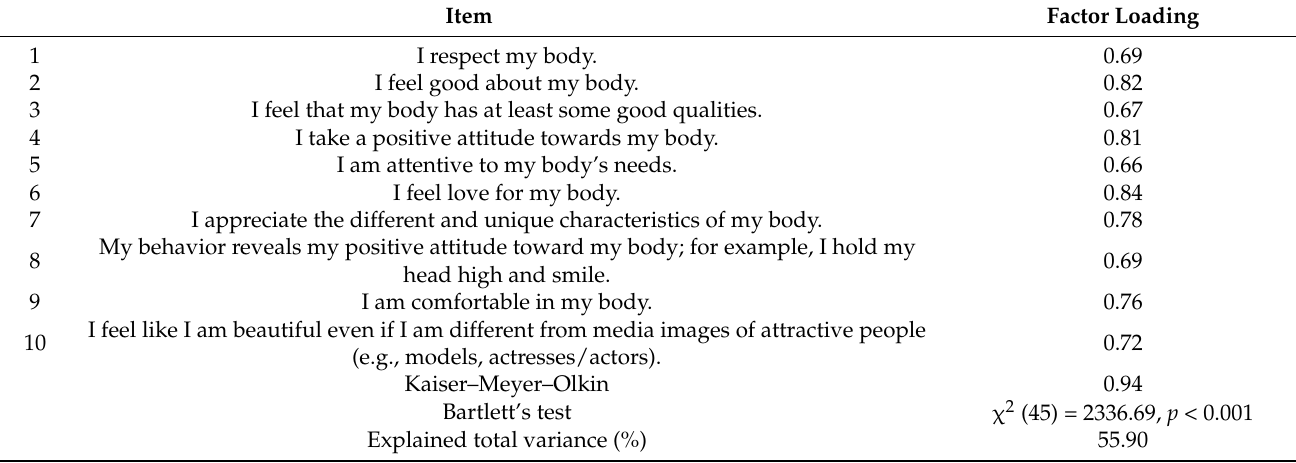
Table 1. Summary of Exploratory Factor Analysis Results in Study